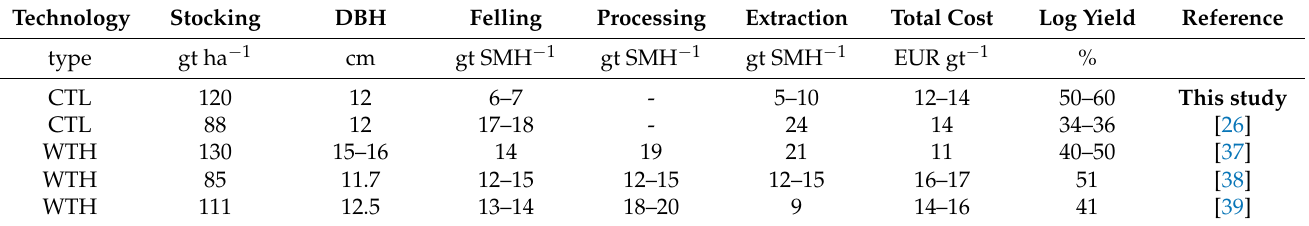
Table 5. Comparison with the results of other recent studies on the same stand and operation